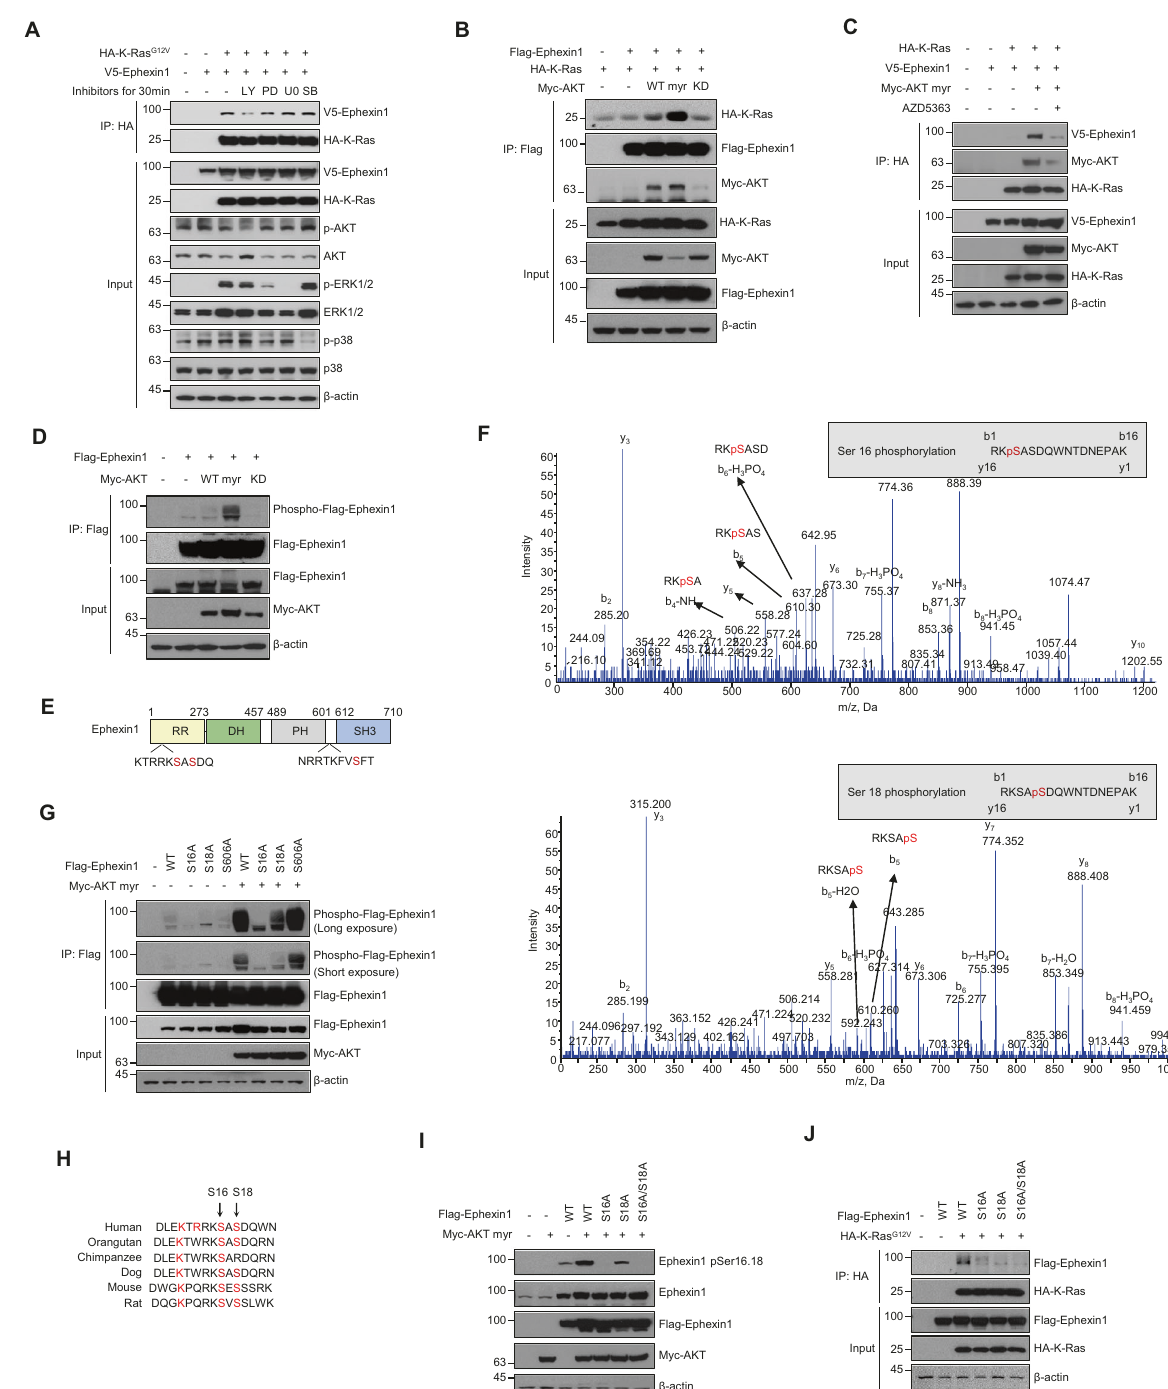
To further verify a correlation between Ephexin1 and Ras, we performed RNA-seq analysis in Ephexin1 knockdown H1299 cells. Bioinformatic analysis revealed 382 differentially expressed genes (Fig. 2E). Importantly, genes normally upregulated by K-Ras were downregulated in Ephexin1 knockdown H1299 cells. And con- sistent with this trend, the genes normally downregulated by K-Ras were upregulated in Ephexin1 knockdown H1299 cells (Fig. 2F). GSEA and heatmaps con fi rmed this positive correlation between Ephexin1 expression and expression of K-Ras (Fig. 2G, H). Moreover, MEK (MAP2K1) target genes (MEK_UP.V1_UP: http://